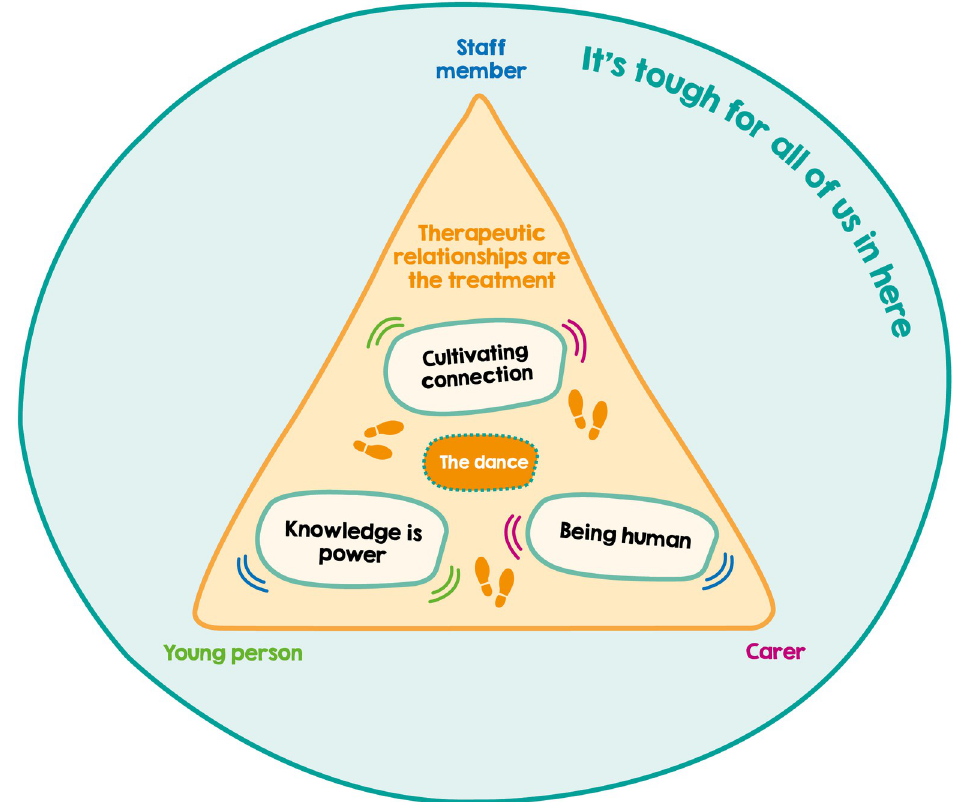
Fig 2. Conceptual diagram of